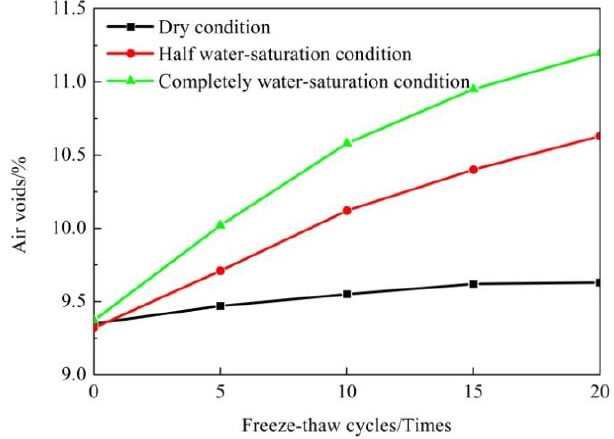
Figure 3. Air voids under freeze – thaw cycles with different water saturation conditions.